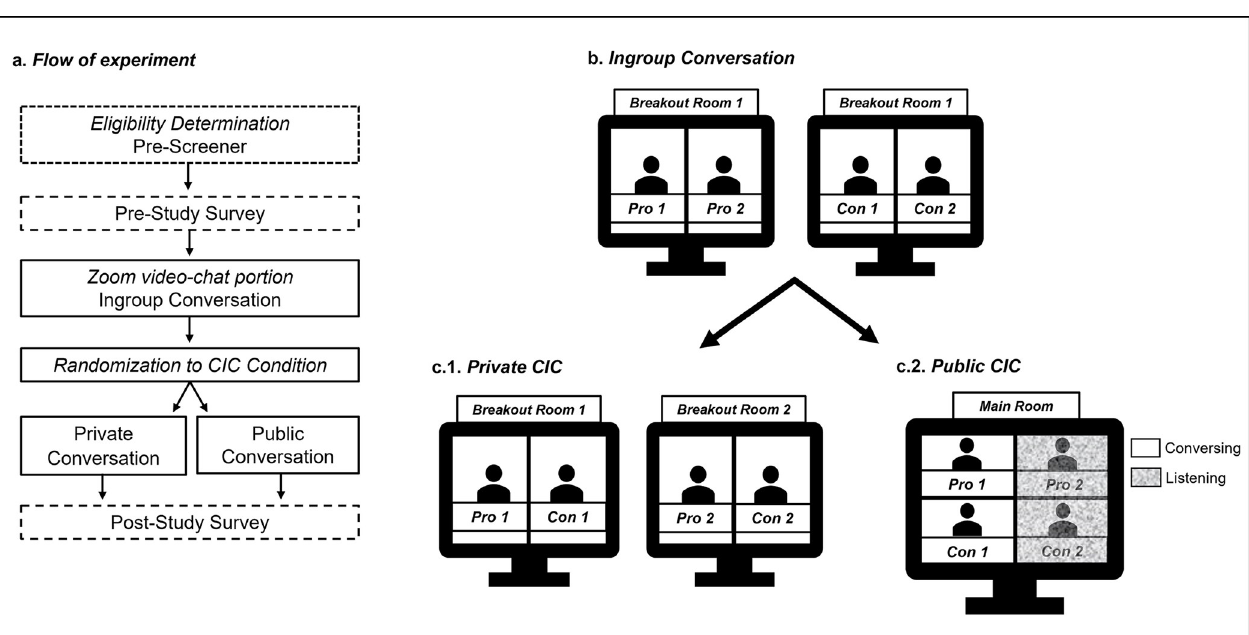
Fig 5. Flow of the experimental Zoom paradigm. Note . a. Flow of the study b. the ingroup conversation consisted of two simultaneous 10-minute conversations with two participants of the same attitude on the issue c. the CICs consisted of two 15-minute conversations with a participant of the opposing attitude on the issue (c.1) the public condition included all four of the participants from the ingroup conversation, with pro 2 and con 2 silently listening while pro 1 and con 1 discussed the issue, after which pro 2 and con 2 had a 15-minute CIC while pro 1 and con 1 silently listened (c.2) in the private condition two simultaneous CICs occurred in separate breakout rooms with one participant from each side of the